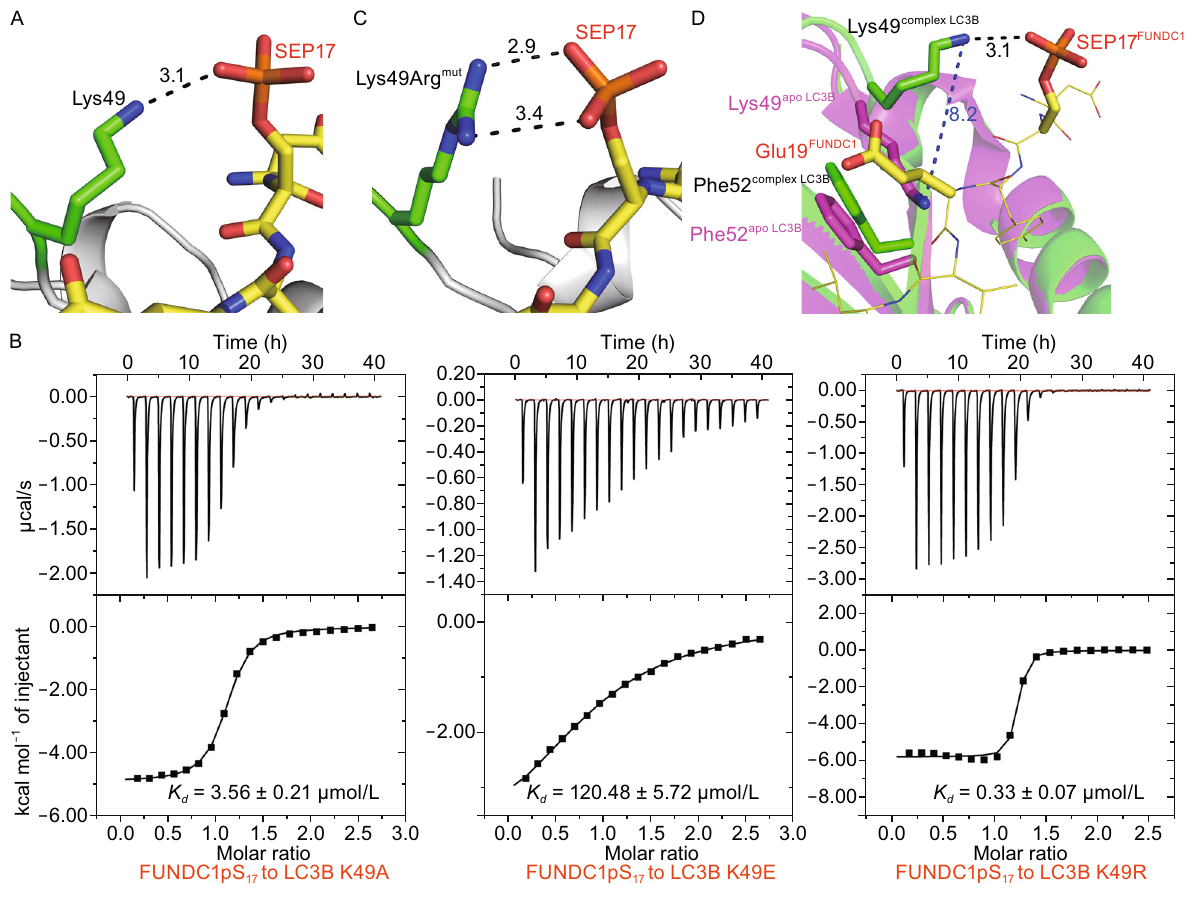
Fig. 5. Molecular basis for the speci fi c recognition between LC3B Lys49 and phosphorylated Ser17 in FUNDC1. (A) Interaction of LC3B Lys49 (green) with the phosphate group of FUNDC1 SEP17 (orange). The surrounding structure of LC3B is represented in grey. Hydrogen bonds are indicated as black dashes. (B) The ITC fi tting results of FUNDC1 pS17 peptide with LC3B mutant at the Lys49 position. (C) The hypothetical model of the interaction between Lys49Arg mut (K49R mut mutated in PyMOL) and the phosphate group of FUNDC1 SEP17. (D) The superimposition of the LC3B-FUNDC1 complex and apo LC3B. The LC3B in complex is colored green and labeled in black while the FUNDC1 pS17 peptide is colored yellow and labeled in red. The apo LC3B is colored and labeled in magenta. The shift of LC3B Lys49 is represented by blue